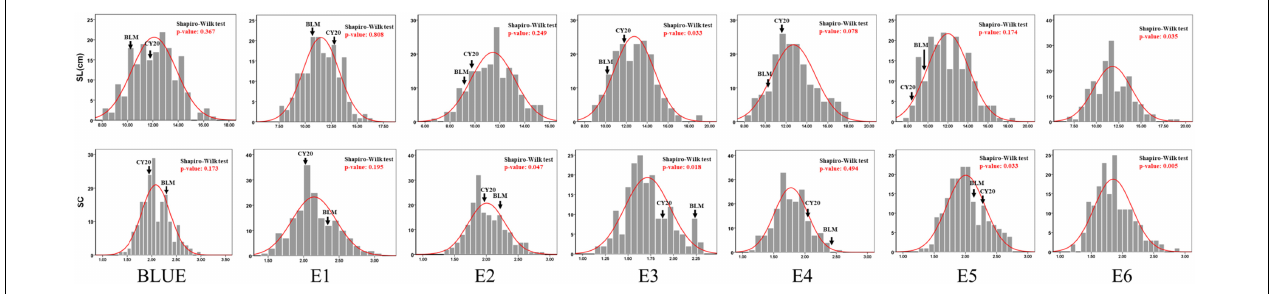
FIGURE 2 | Frequency distribution of BC20 lines for spikelet compactness (SC) and spike length (SL) in six environments and the BLUE